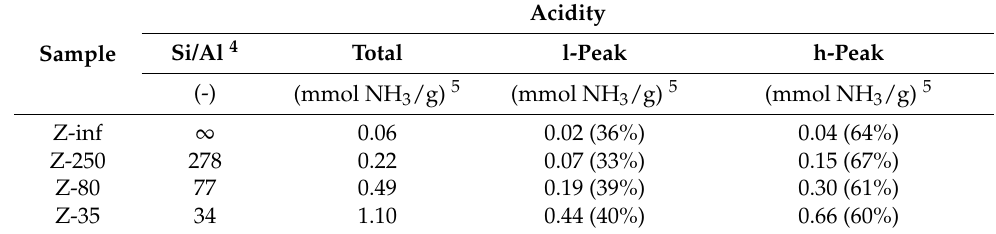
Figure A2. 4 ICP ‐ OES; analysis of Si and Al content of samples after digestion. 5 TPAD; tempera ‐ ture ‐ programmed ammonia desorption ‐ calculation of specific amount of NH 3 adsorbed on the solid ‐ state surface, separated into a low(l) ‐ and high(h) ‐ temperature peak.